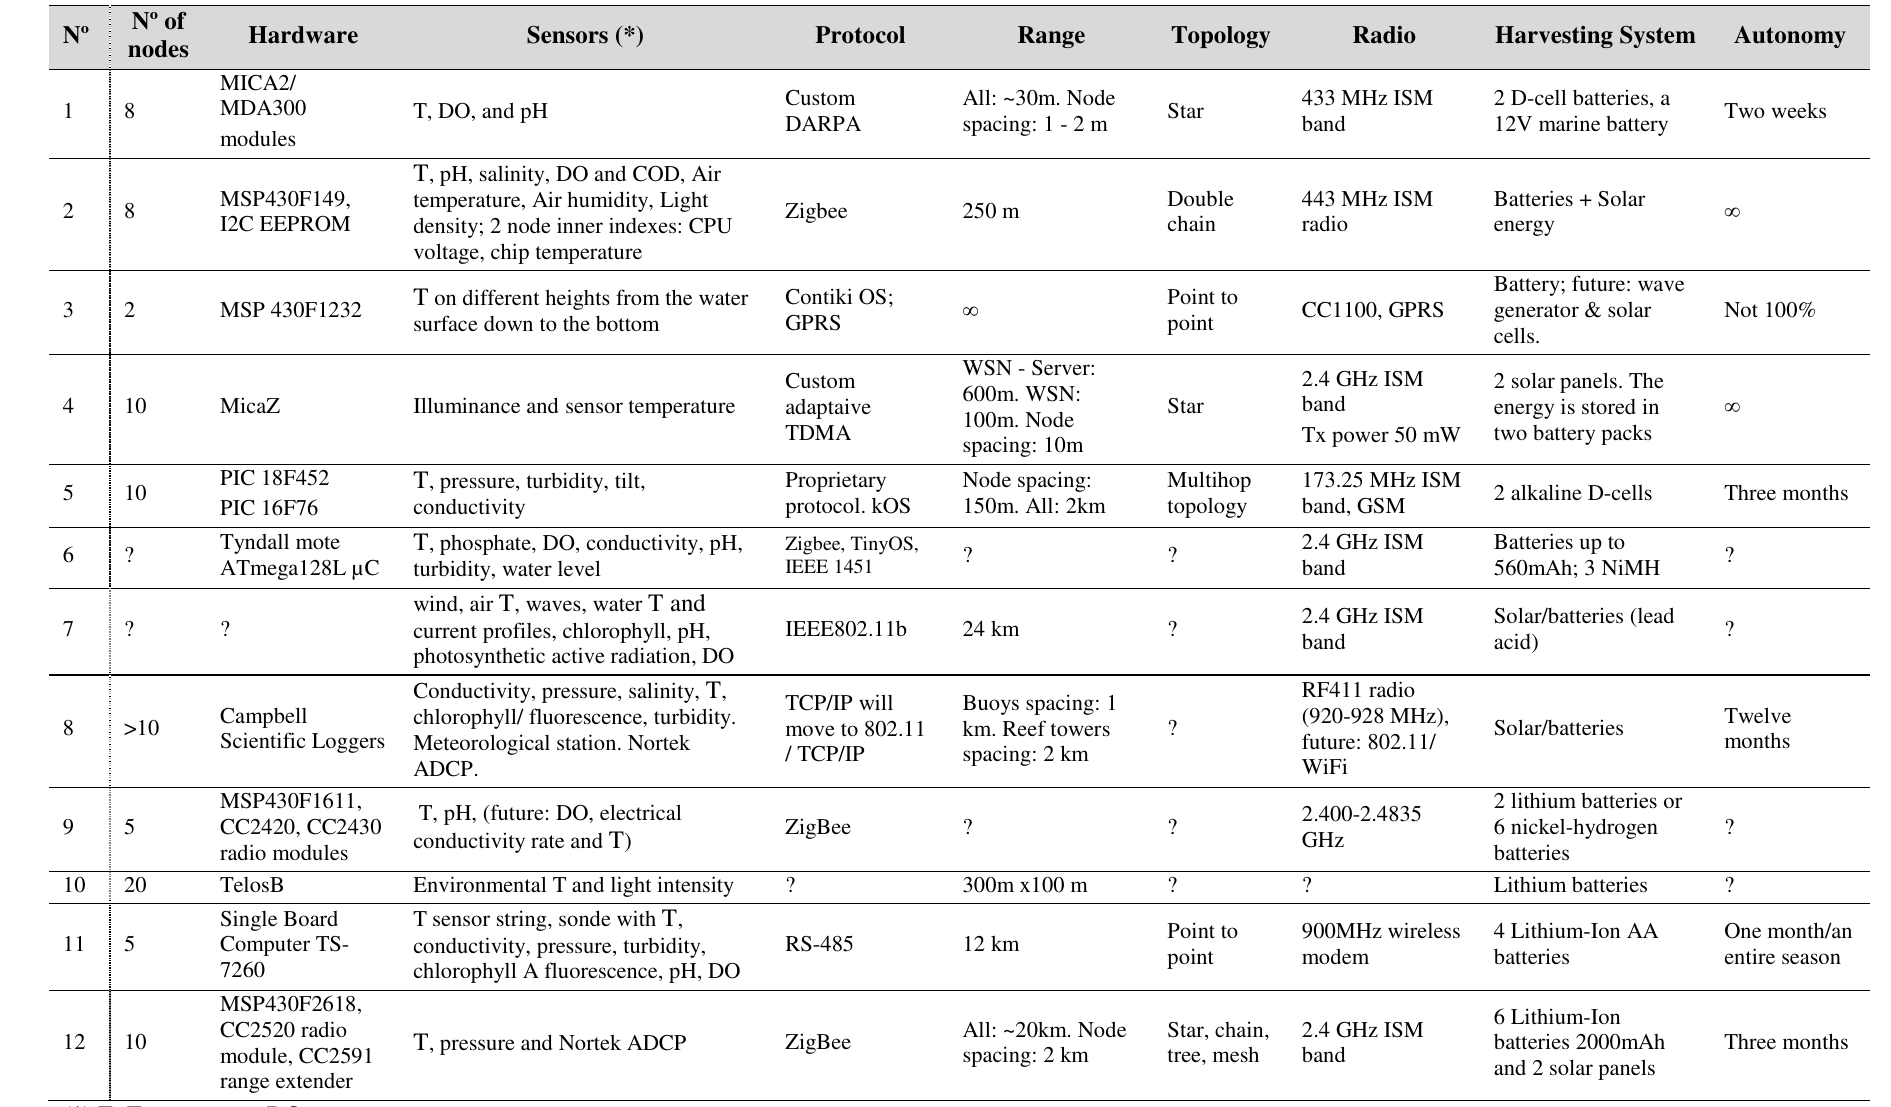
Table 5. Systematic review results: Technical